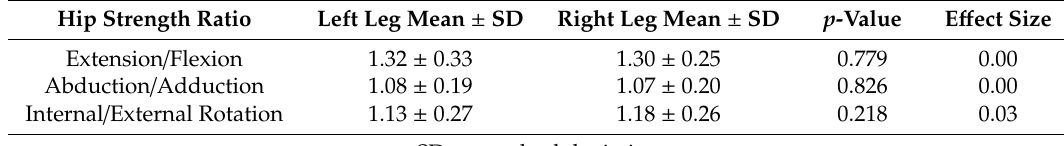
Table 4. Hip strength ratio di ff erences between left and right leg (Mann–Whitney U test). Hip Strength Ratio Left Leg Mean ± SD Right Leg Mean ± SD p -Value E ff ect Size Extension / Flexion 1.32 ± 0.33 1.30 ± 0.25 0.779 0.00 Abduction / Adduction 1.08 ± 0.19 1.07 ± 0.20 0.826 0.00 Internal / External Rotation 1.13 ± 0.27 1.18 ± 0.26 0.218 0.03 SD = standard deviation